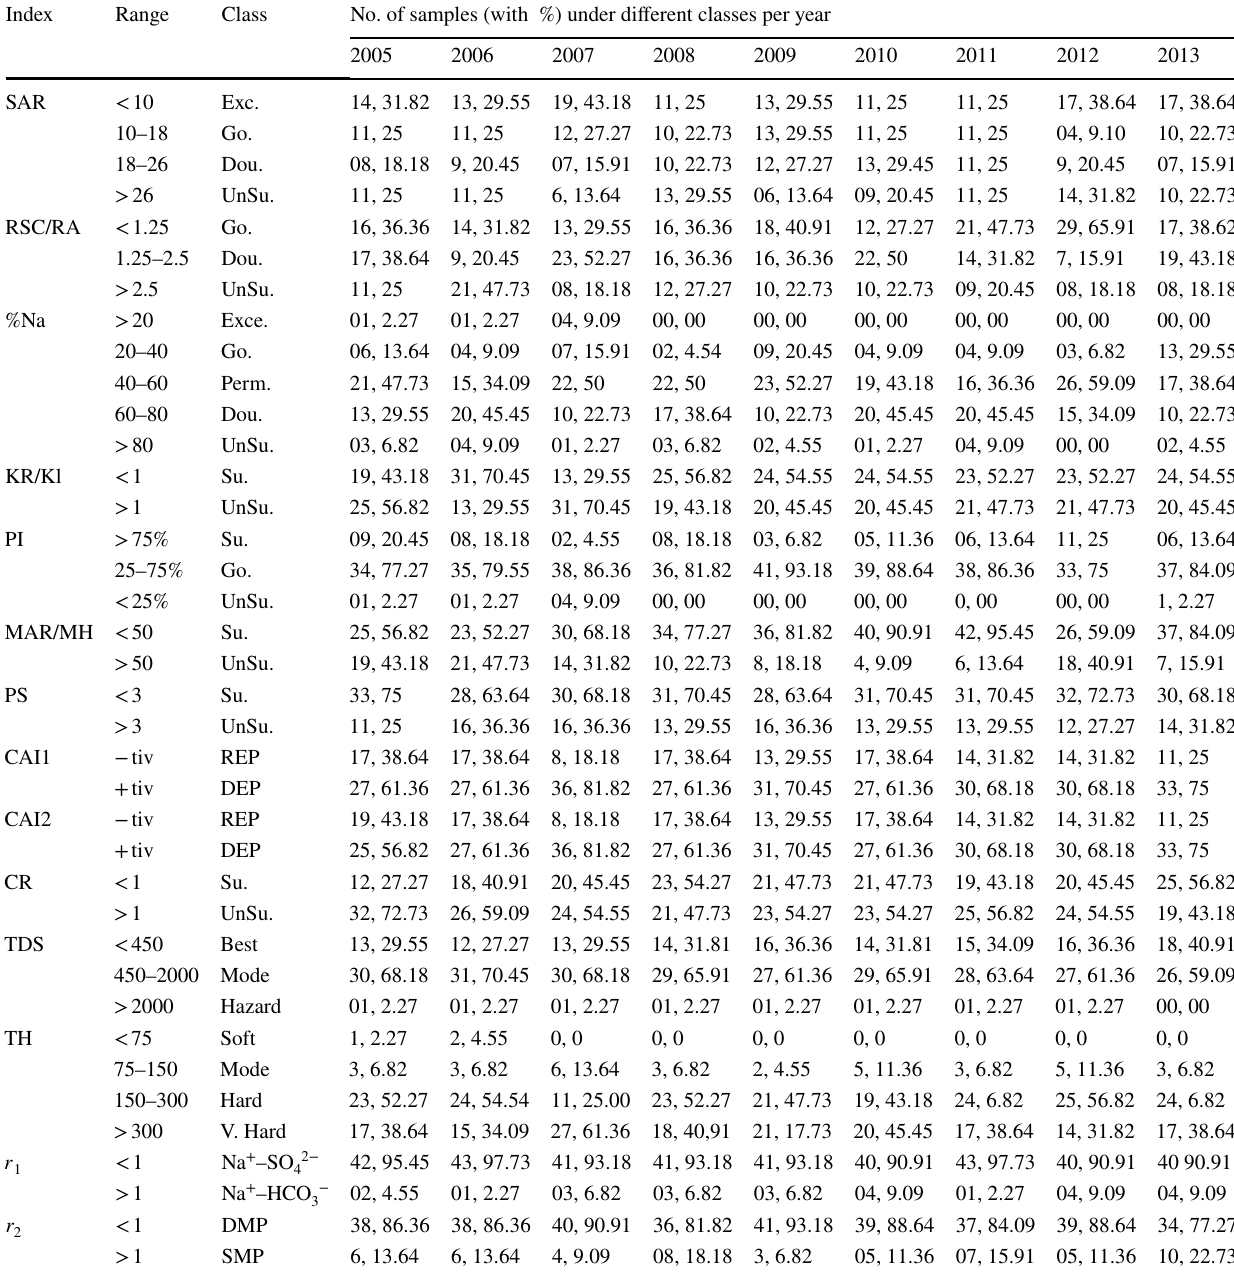
Table 4 Classification of fixed bore wells water during pre-monsoon within the study area for irrigation based on %Na, SAR, MH, KR